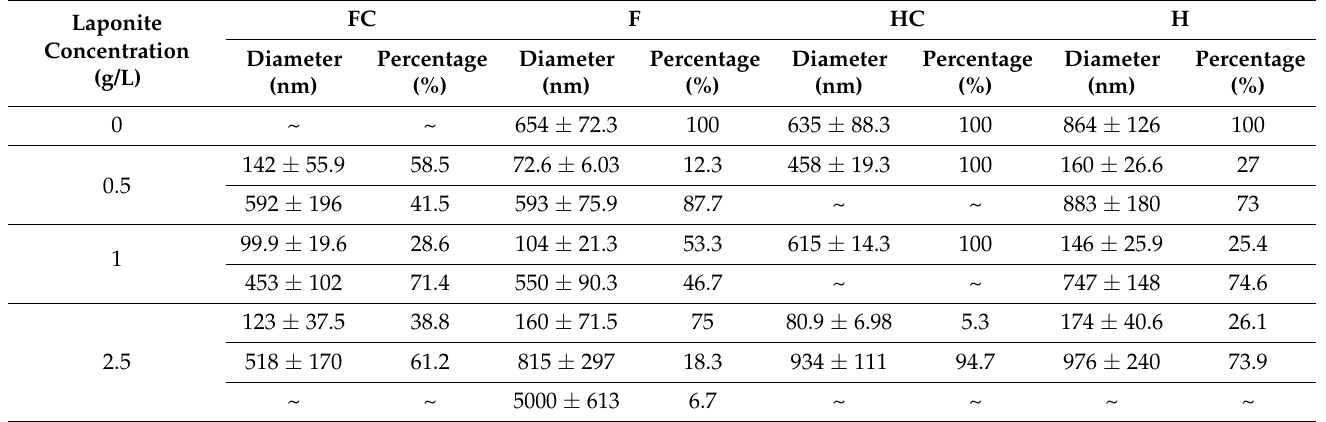
Table 2. Particle size distribution of laponite nanoparticles after the bioreduction of the Fe (III) in HFO or ferric